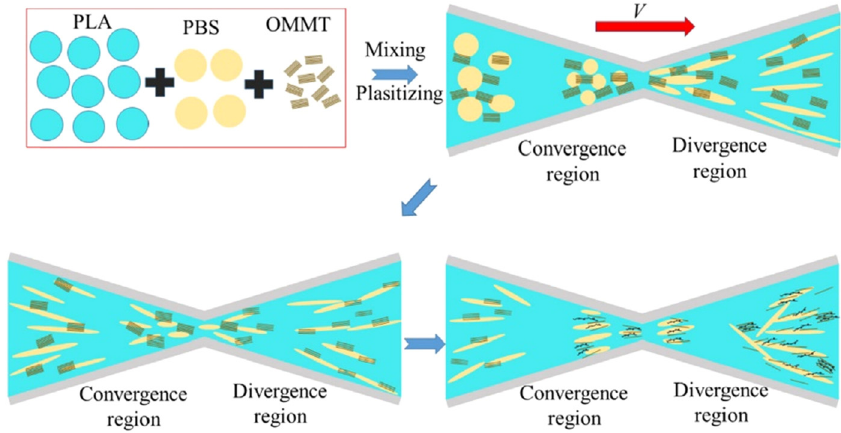
Figure 4: Evolution of the dispersion, intercalation, and exfoliation of OMMT in a blend ( 44 ) . Copyright 2019. Reproduced with permission from